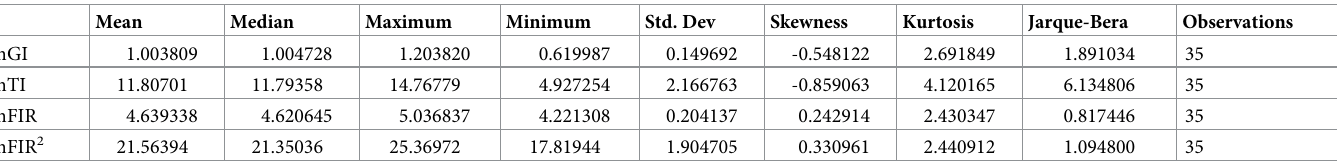
Table 1. Descriptive statistics